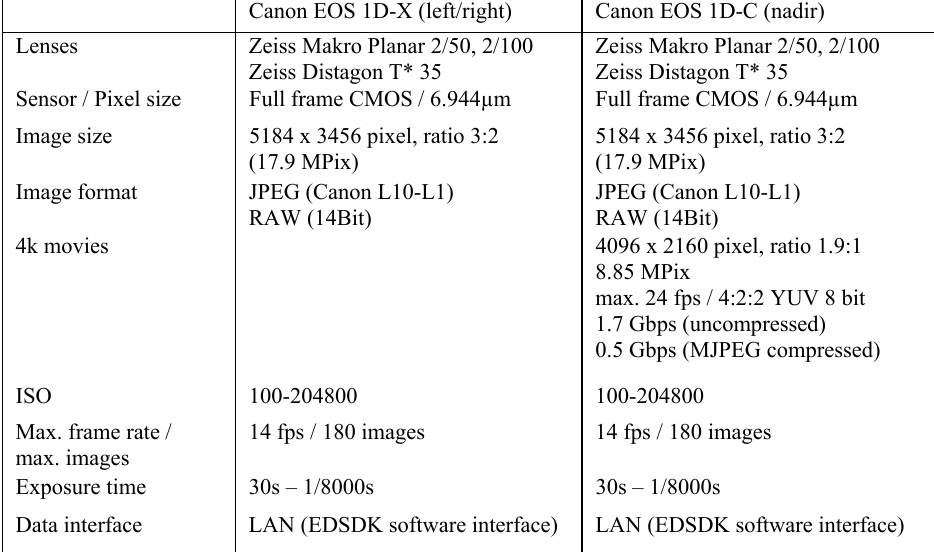
Table 2. Properties of the 4k cameras